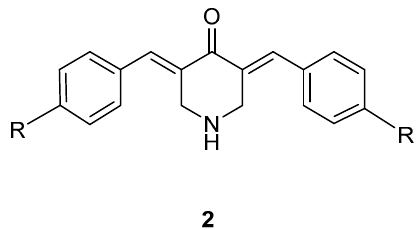
Figure 2. Cytotoxic 3,5-bis(benzylidene)-4-piperidones 2 .